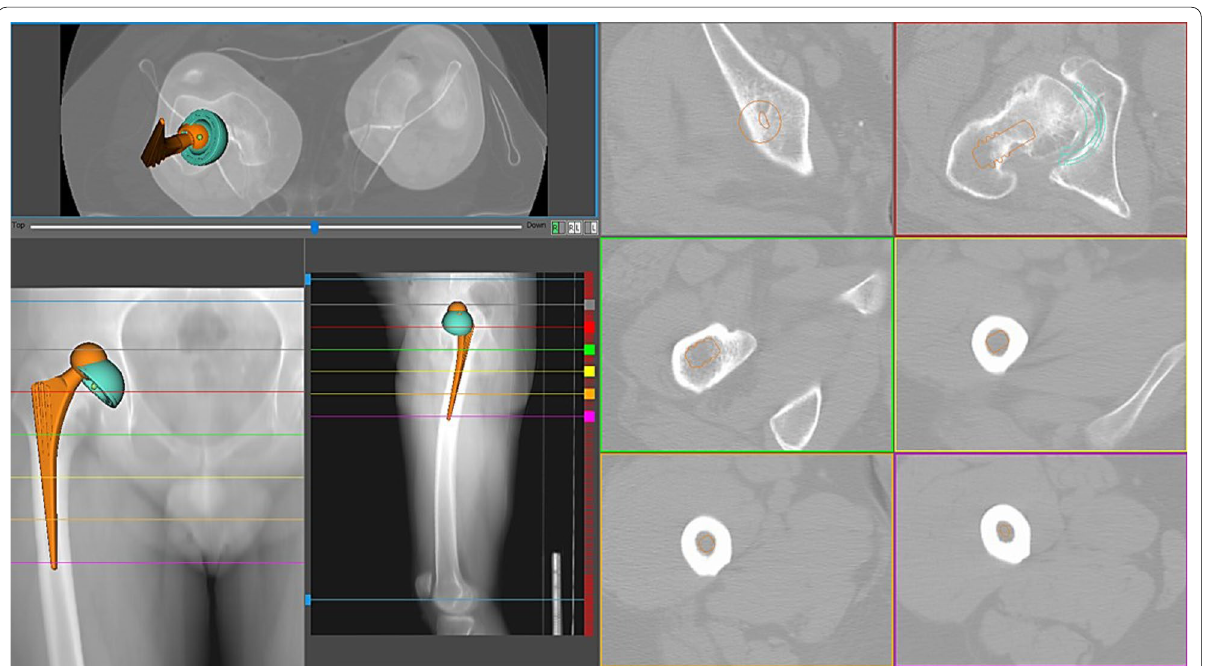
Fig. 2 A single wedge stem simulation was performed in the Crowe II right hip of a 41-year-old male (native femoral anteversion 24°). The single wedge stem matched all the reconstructive parameters and achieved an acceptable